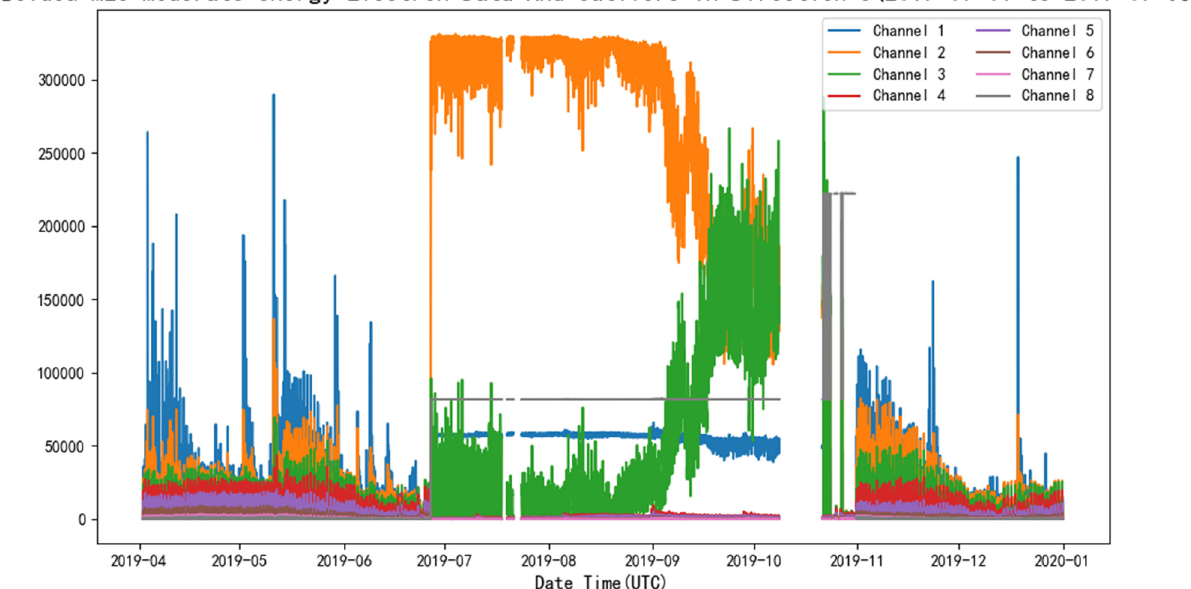
Figure 4: Outliers in direction 3.